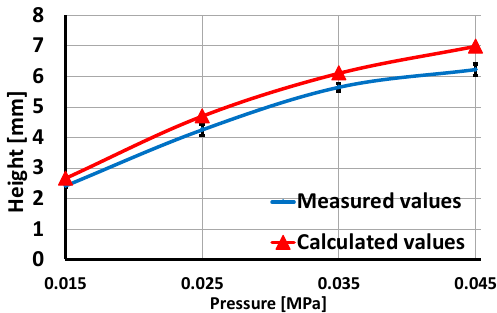
Figure 11. Comparison of calculated and measured values of inflated skin’s height.